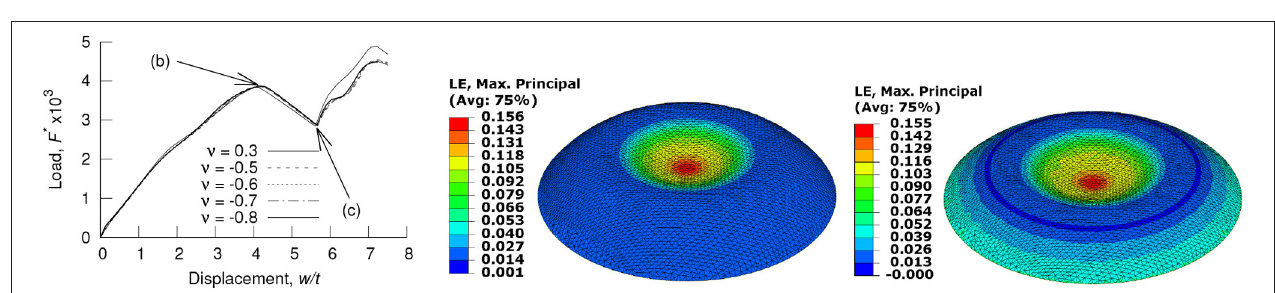
FIGURE 1 | The four cellular topologies considered here (Left) : (a) hexagonal, (b) re-entrant, (c) arrow, and (d) tri-chiral. An arrow-head dome PLA specimen (Left) and the spherical dome dimensions (Right) . The sphere radius is 50 mm. The dome height is 20 mm and the dome base radius is 40 mm.